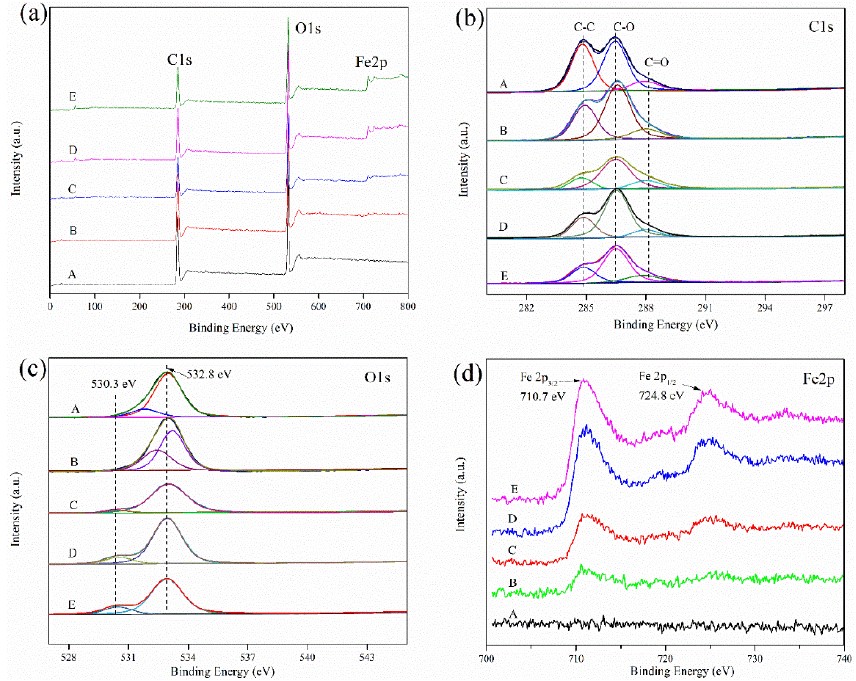
Figure 9. ( a ) XPS survey spectra; ( b ) C 1s XPS spectrum; ( c ) O 1s XPS spectrum and ( d ) Fe 2p XPS spectrum of binderless fiberboard and NFF binderless composite board. (a. fiberboard; b. NFF1 board; c. NFF2 board; d. NFF3 board; e. NFF4 board).